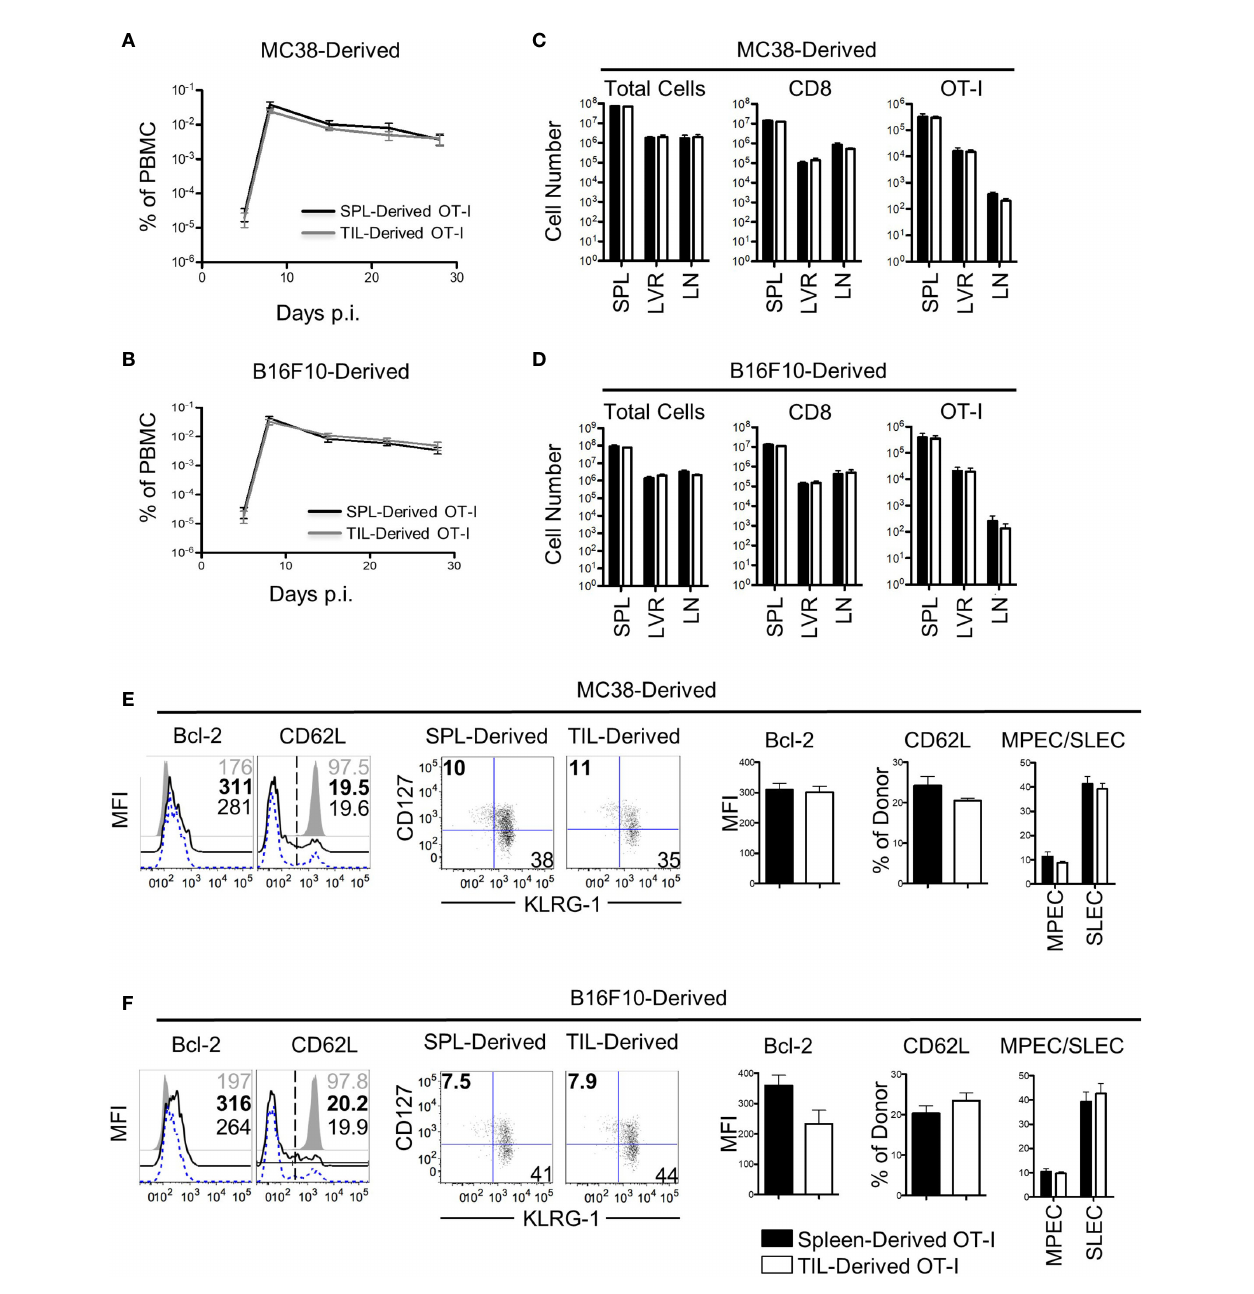
FIGURE 4 | Bystander memory CD8 T cells from the tumor microenvironment retain their recall ability. Bystander memory CD8 T cells were isolated from TILs or spleens of mice bearing MC38-GP33 tumors and were sorted by FACS. 4000 OT-I bystander memory cells were adoptively transferred in naïve B6 mice and subsequently infected with 15k CFU of Lm-Ova. (A, C) . Mice were bled to follow donor expansion and contraction. Spleen (SPL)-derived (black) and TIL-derived (gray) bystander memory cells are plotted as percent of total PBMC. Bystander memory isolated from MC38-GP33 bearing mice are shown in (A) and bystander memory from B16.F10-GP33 bearing mice in (C, D) . At day 28, tissues were collected from these mice and donor cells from SPL, liver (LVR) and lymph node (LN) were analyzed. The total number of cells, total number of CD8 T cells, and OT-I donor cells are quanti fi ed from spleen-derived donors (black bars) and tumor-derived donors (white bars). Bystander memory isolated from MC38-GP33 bearing mice are shown in (B) and bystander memory from B16.F10-Gp33 bearing mice in (D, E) Spleens samples of mice that received donors originating from MC38-GP33 bearing mice (E) or from B16.F10-GP33 (F) were stained for phenotypic markers. Histograms depict the mean fl uorescence intensity (MFI) or percent of cells expressing the given marker. Quanti fi cation of each marker is shown to the right. Short- live effector cells (SLEC) were gated on KLRG1+CD127- populations and memory precursor effector cells (MPEC) were gated on KLRG1-CD127+ populations. Unpaired T-tests were run to compare the SPL-derived donors to the TIL-derived donors with no signi fi cant differences found between any groups. N=5 mice per group. Data is representative of 2 independent